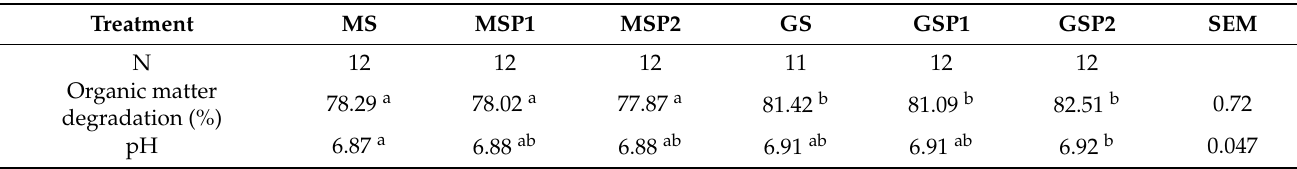
Table 3. Organic matter degradation (%) and pH after 48 h of fermentation of grass silage (GS) and maize silage (MS) with or without probiotic 1 (P1) or probiotic 2 (P2) in rumen fluid (data from 2 laboratories).